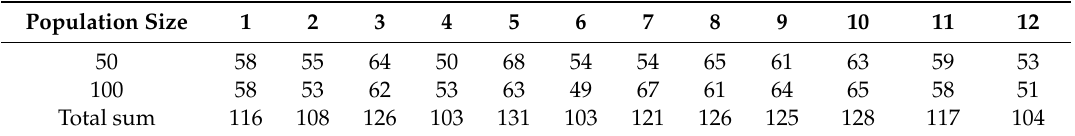
Table 11. Holm test, p-value = 0.05.